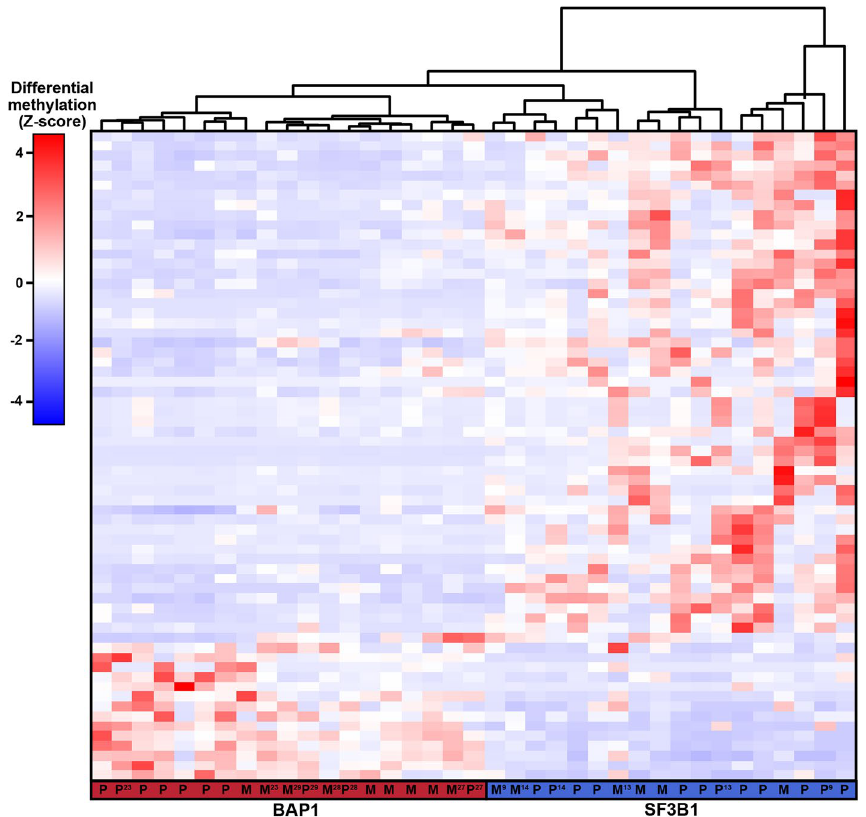
Figure 3. Heatmap visualizing the clustering of primary UM (P) and UM metastases (M) based on DMR with a FC > 5. SF3B1 -mutated primary UM show a similar methylome as SF3B1 -mutated metastases and the same is observed for the BAP1 -mutated primary UM and BAP1 -mutated metastases. Red indicates hypermethylation, whereas blue indicated hypomethylation of the DMR. Matched primary UM and metastases samples are marked by their sample number (UM23, UM27, UM28, UM29, UM9, UM13,